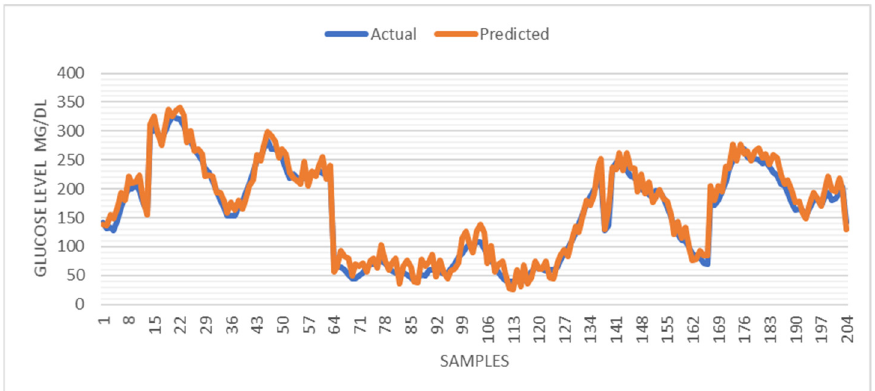
Figure 6. The predicted glucose level using the RNN-RBM model versus the actual level.